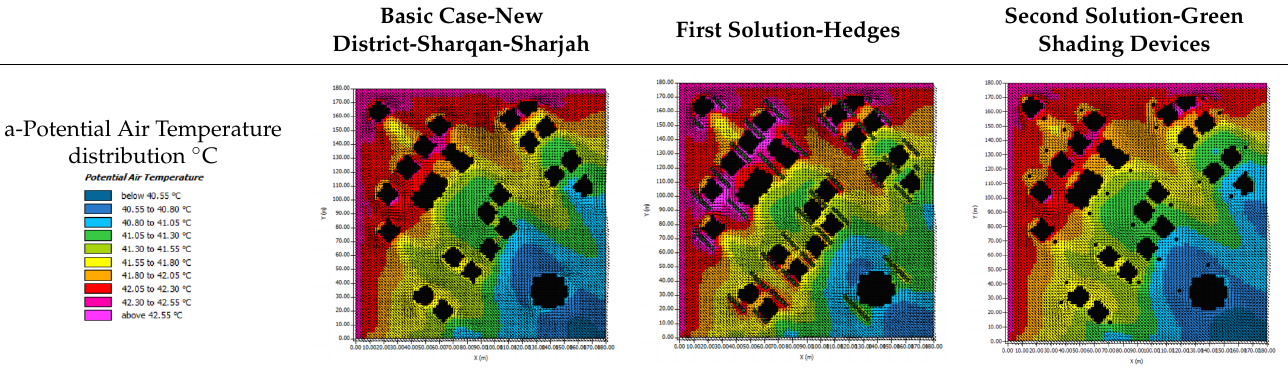
Table 7. The potential air temperature distribution and PMV for the base new case and the solutions at 12:00 pm on 21st of August at height of 1.8 m. Basic Case-New